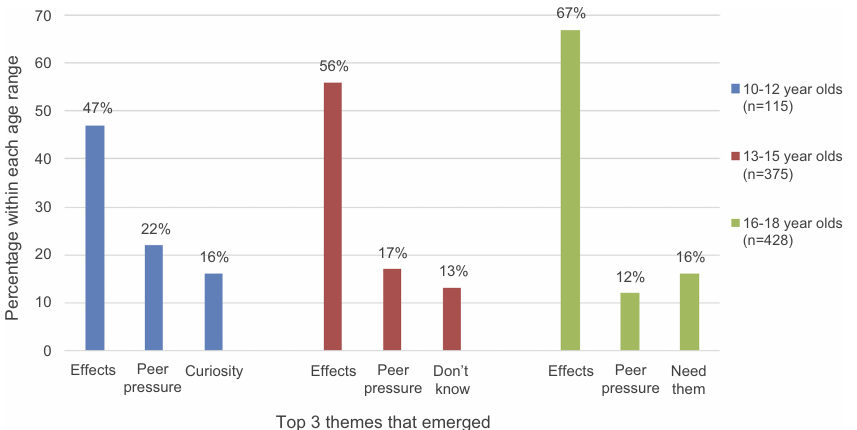
Figure 4. Why do people use prescription stimulants without a